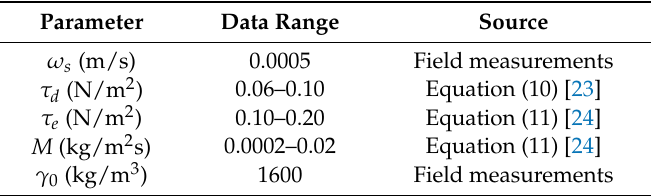
Table 4. Parameter values adopted in the model.